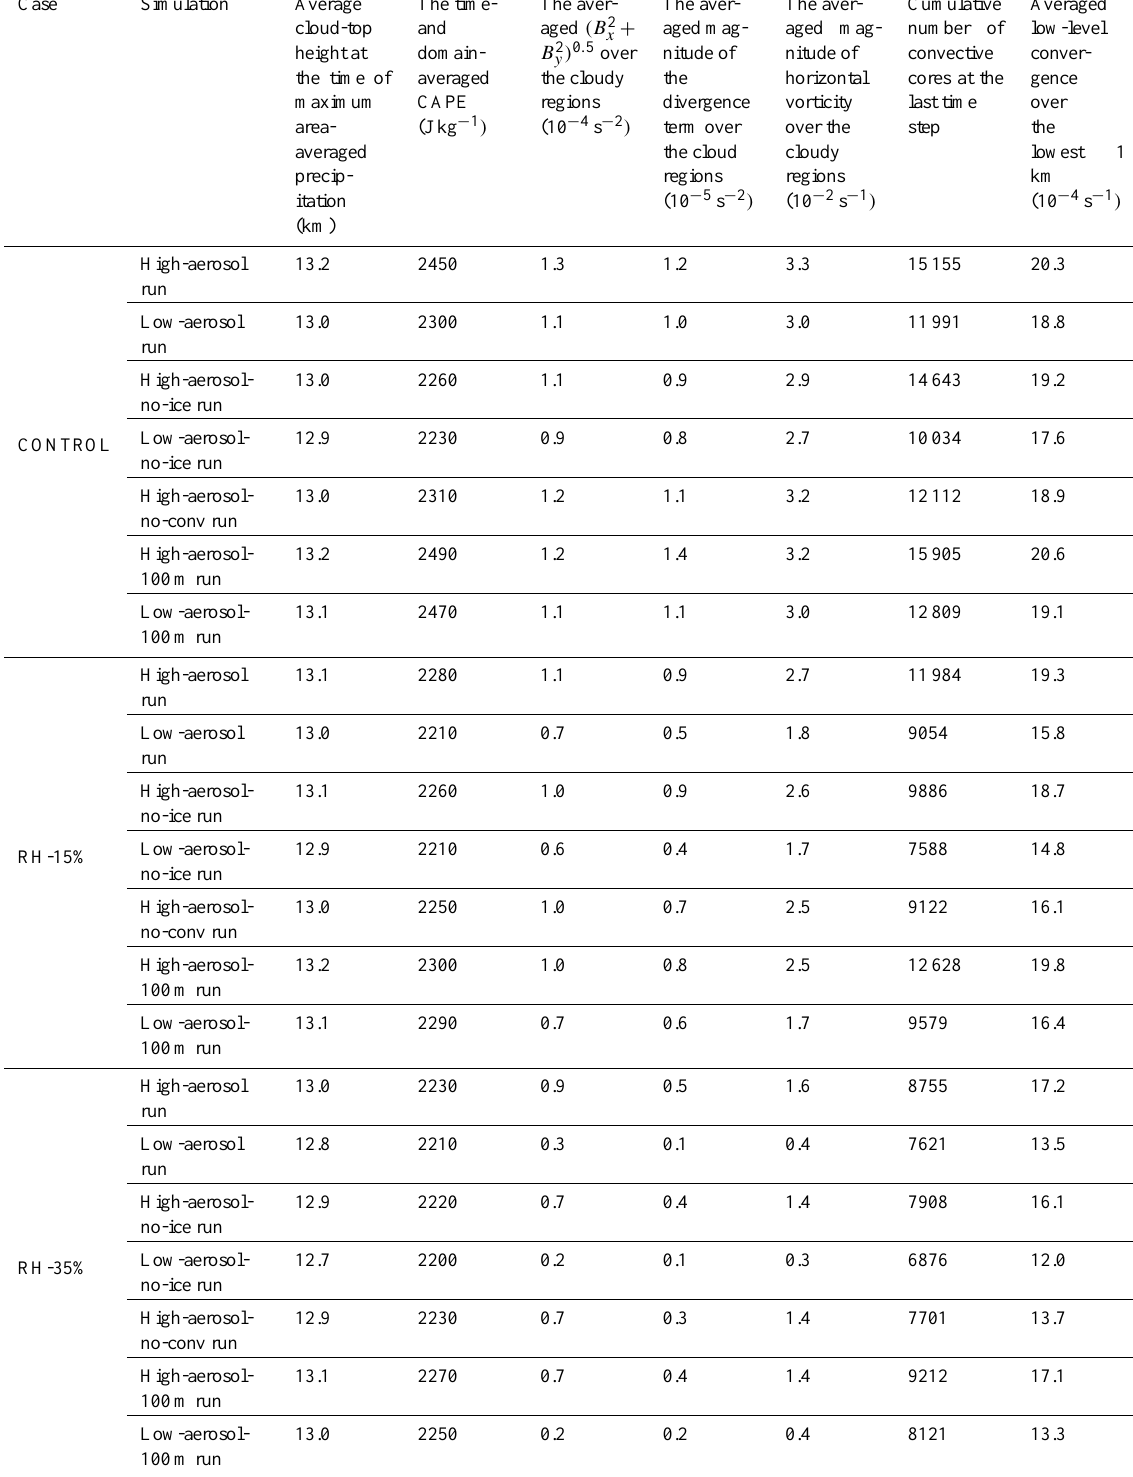
Table 6. Averaged horizontal buoyancy gradient and vorticity and terms characterizing the cloud type and the low-level convergence.